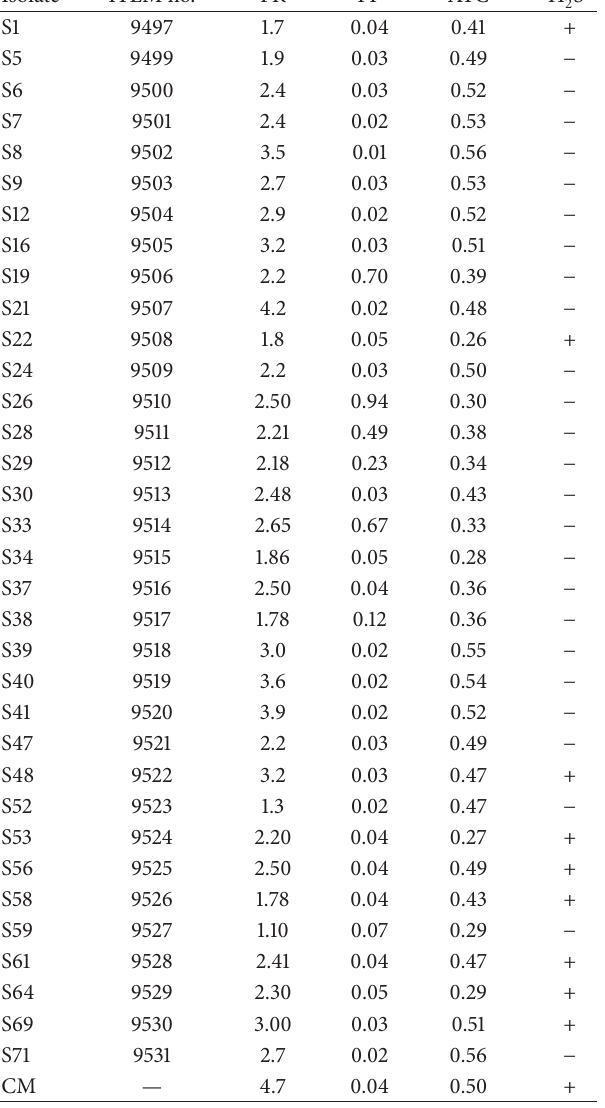
Data, measured at the end of fermentation, represent the average of three replicates. ITEM: ISPA’s agrofood toxigenic fungi culture collection. FP:fermentationpurity(volatileacidity(g/L)/ethanol(%v/v)),AYC:alcohol yield coefficient (alcohol (% v/v)/(initial sugars (%) − residual sugars (%))), FR: fermentation rate (g of CO 2 /day, after 3 days of fermentation). a H 2 S production: absent ( − ); low (+), high (++), and very high (+++).